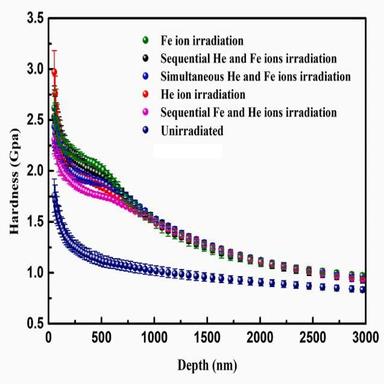
Depth profiles of hardness for various conditions.